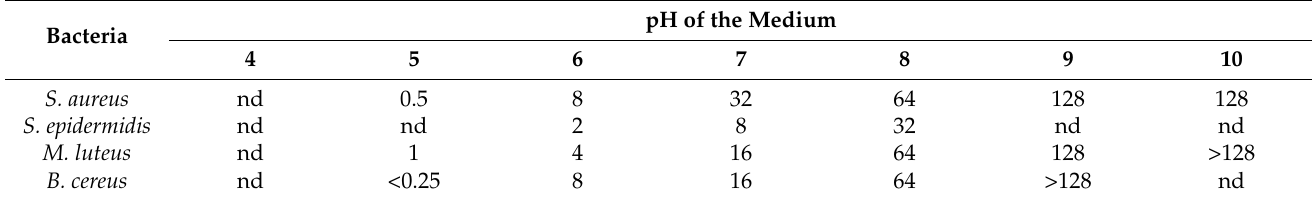
Table 3. Bactericidal activity of compound 26 against Gram-positive bacteria S. aureus , S. epidermidis , M. luteus, and B. cereus at various pH conditions. The values indicate MBC in µ g/mL; nd—no visible growth in control sample. The median values from five independent experiments are